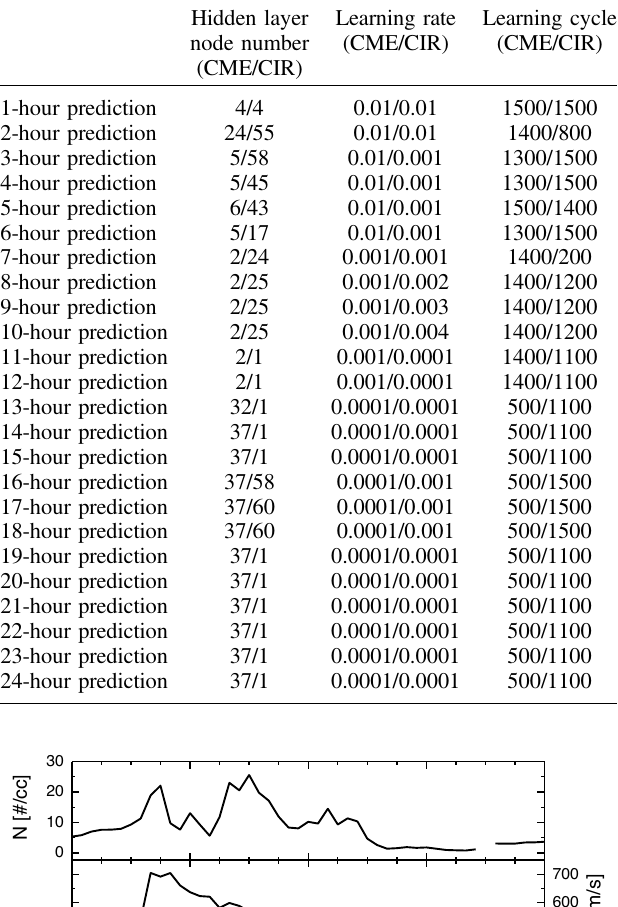
Table 4. Optimized hyperparameters of ANN of combination